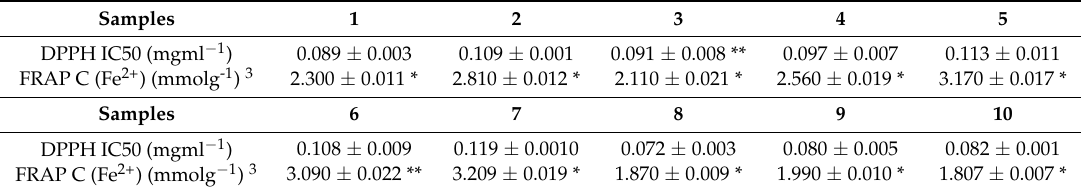
Table 1. Antioxidant activity values for Chrysanthemum morifolium .